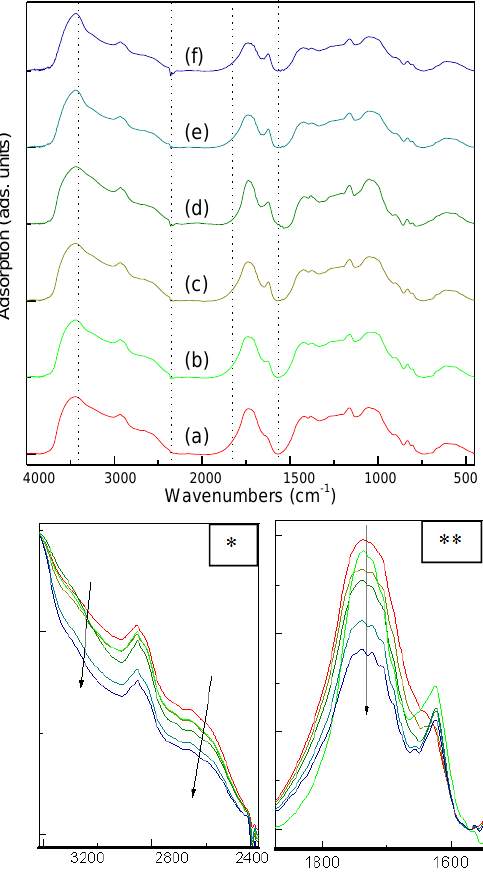
Fig.5. FT-IR spectra of VRS and VRS with Cu 2+ increasing pH; (a) pH 2.5; (b) pH 3; (c) pH 3.5; (d) pH 4; (e) pH 4.5; (f) pH